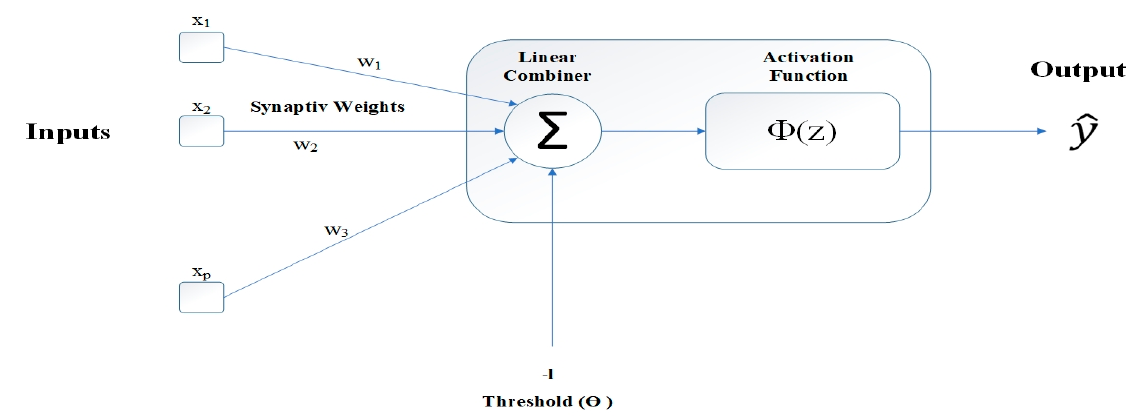
Figure 19. Schematic representation of MLP neuron.